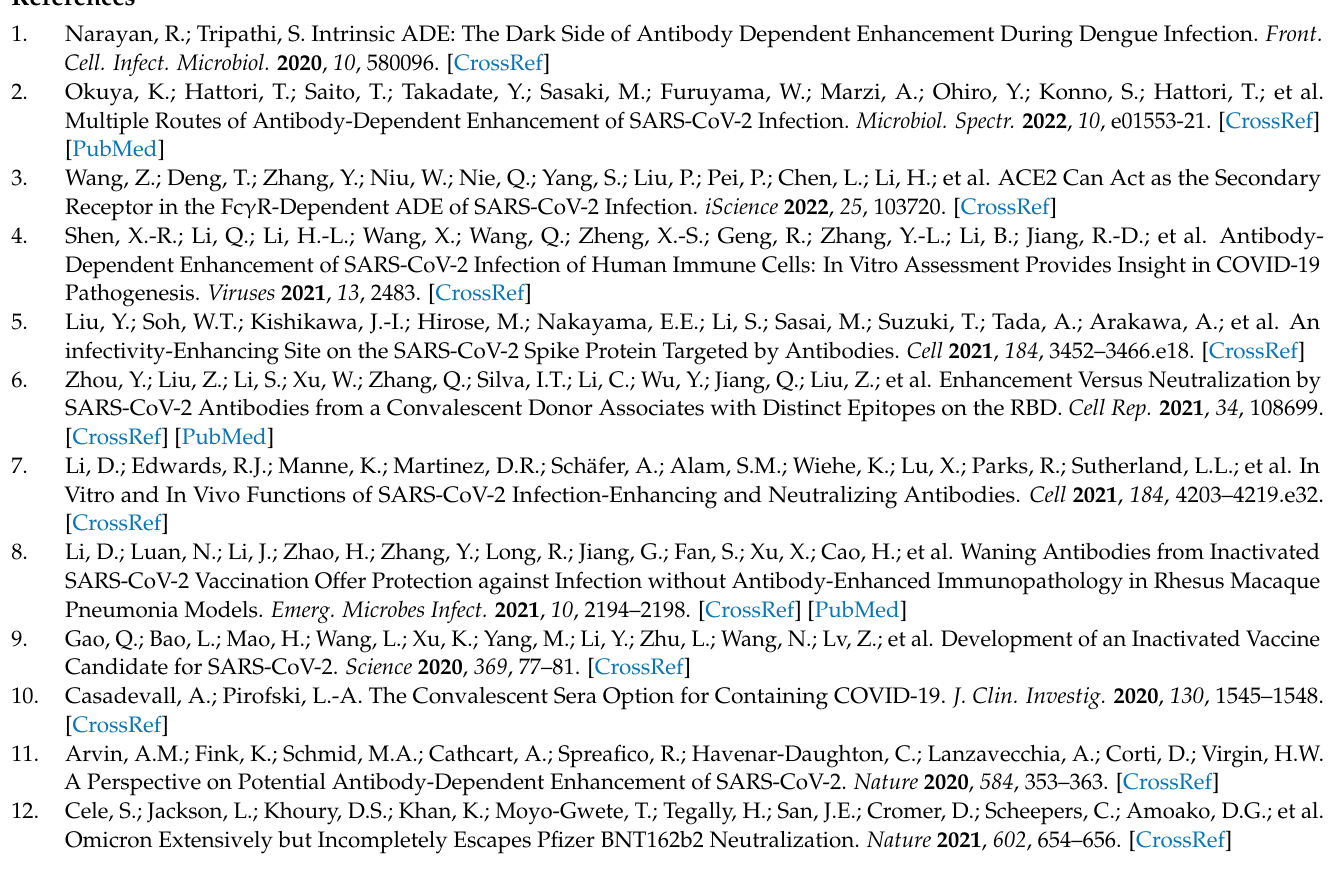
Figure S2: Specific antibody response anti-SARS-CoV-2. Figure S3: Specific antibody response